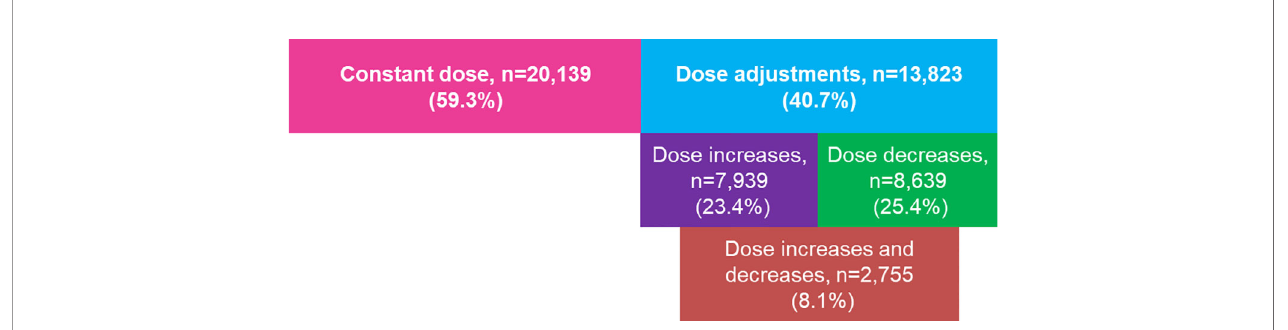
FIGURE 1 | Summary of dose adjustments among cycles. Denominator for calculations is number of cycles (n=33,962). The number of cycles with: a constant dose; ≥ 1 dose adjustment; ≥ 1 dose increase, regardless of any decrease; ≥ 1 dose decrease, regardless of any dose increase; and ≥ 1 dose decrease and ≥